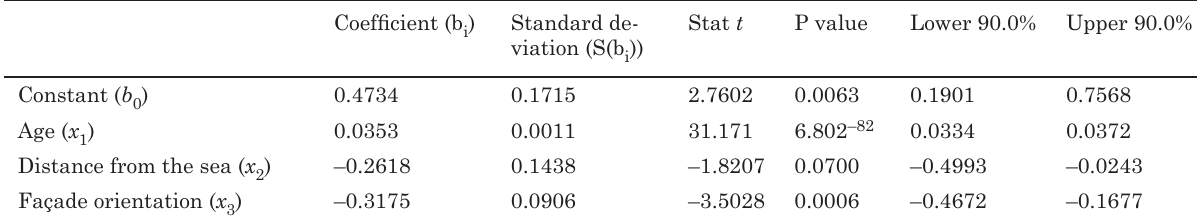
Table 4. ANOVA table of the multiple linear regression model (part 2: regression coefficients and individual analysis of the significance of each regression